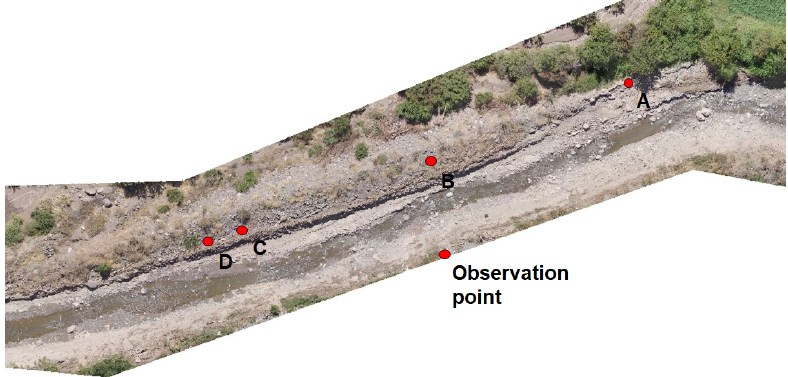
Figure 1. Composite image of the study reach of the Pocuro stream, showing the location of the point from which the video was taken and the control points used to calculate the flow velocity. The flow is from right to